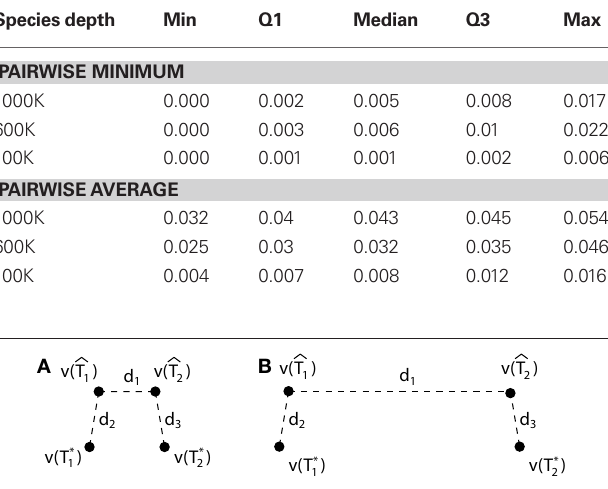
Table 1 | Q1 means the first quartile and Q3 means the third quartile. By “min” we mean the smallest number and “max” means the largest number among a sample. Sequence divergences were calculated in two ways: (i) the pairwise minimum percentage of sequence divergence and (ii) the average pairwise percentage of sequence divergence.